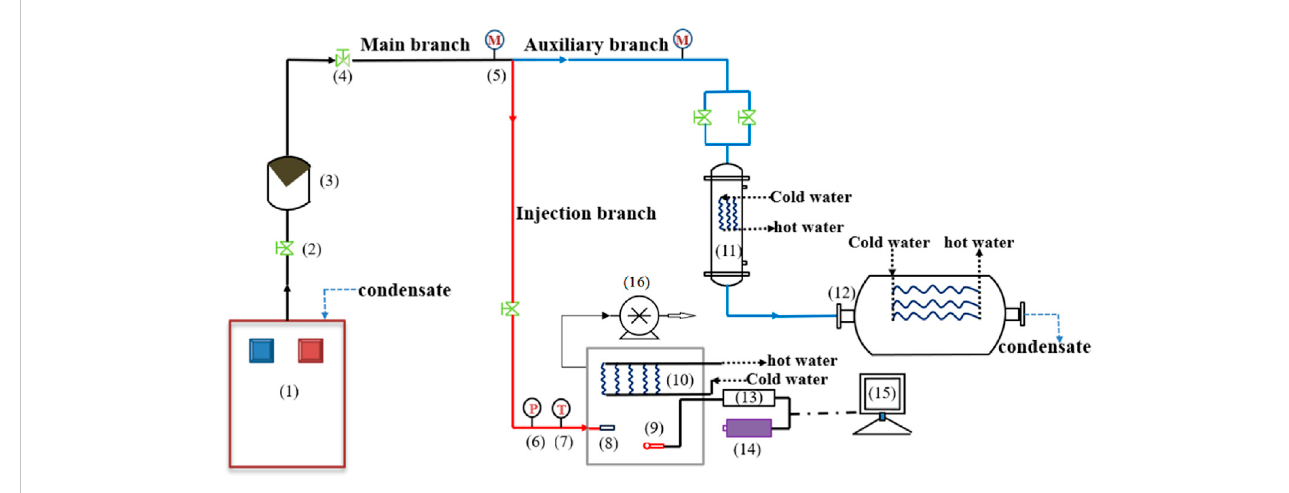
FIGURE 1 Experimental system.